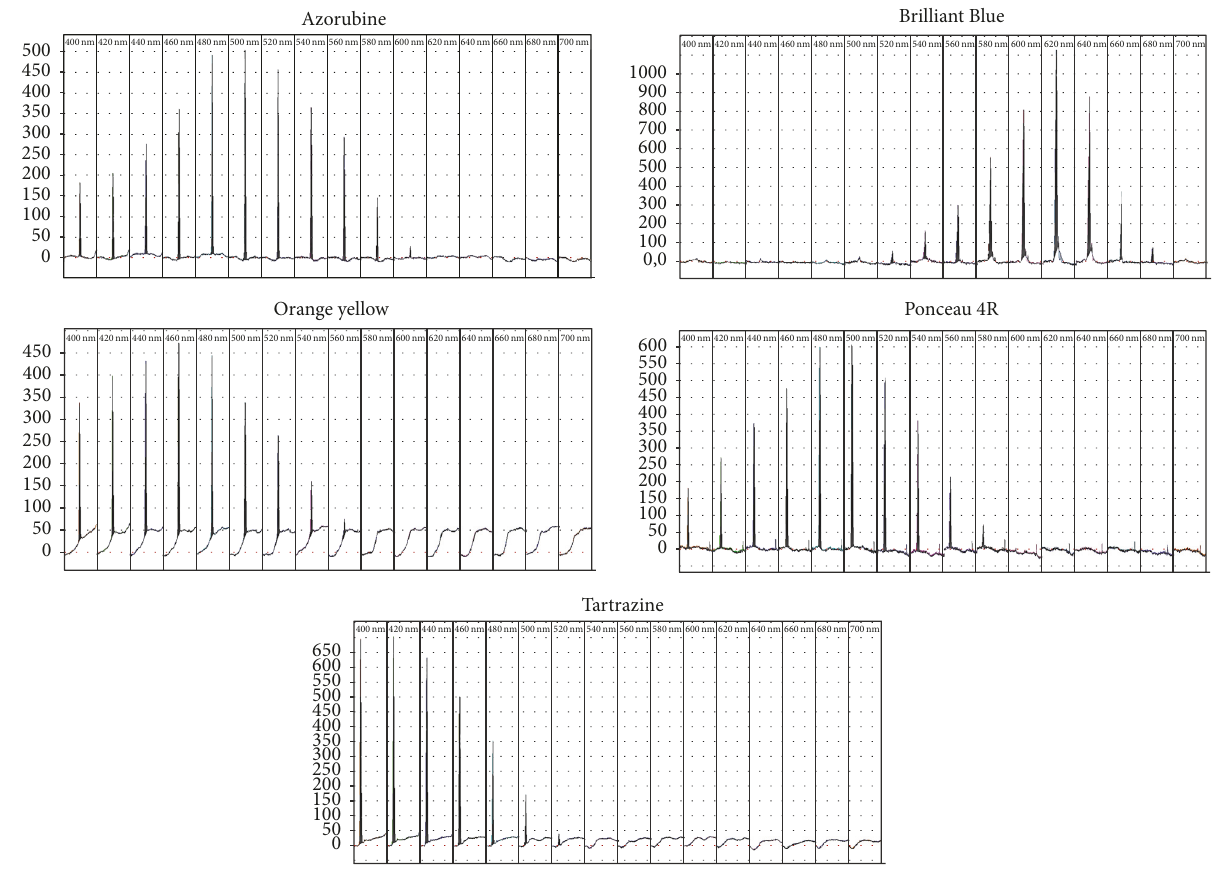
Figure 2: Multiwavelength scans of studied dyes. Table 3: Regression coefficients ( 𝑦 = 𝑎𝑥 2 + 𝑏𝑥 + 𝑐 ) with confidence intervals. Analytical wavelengths selected on the basis of densitometric scanning (Figure